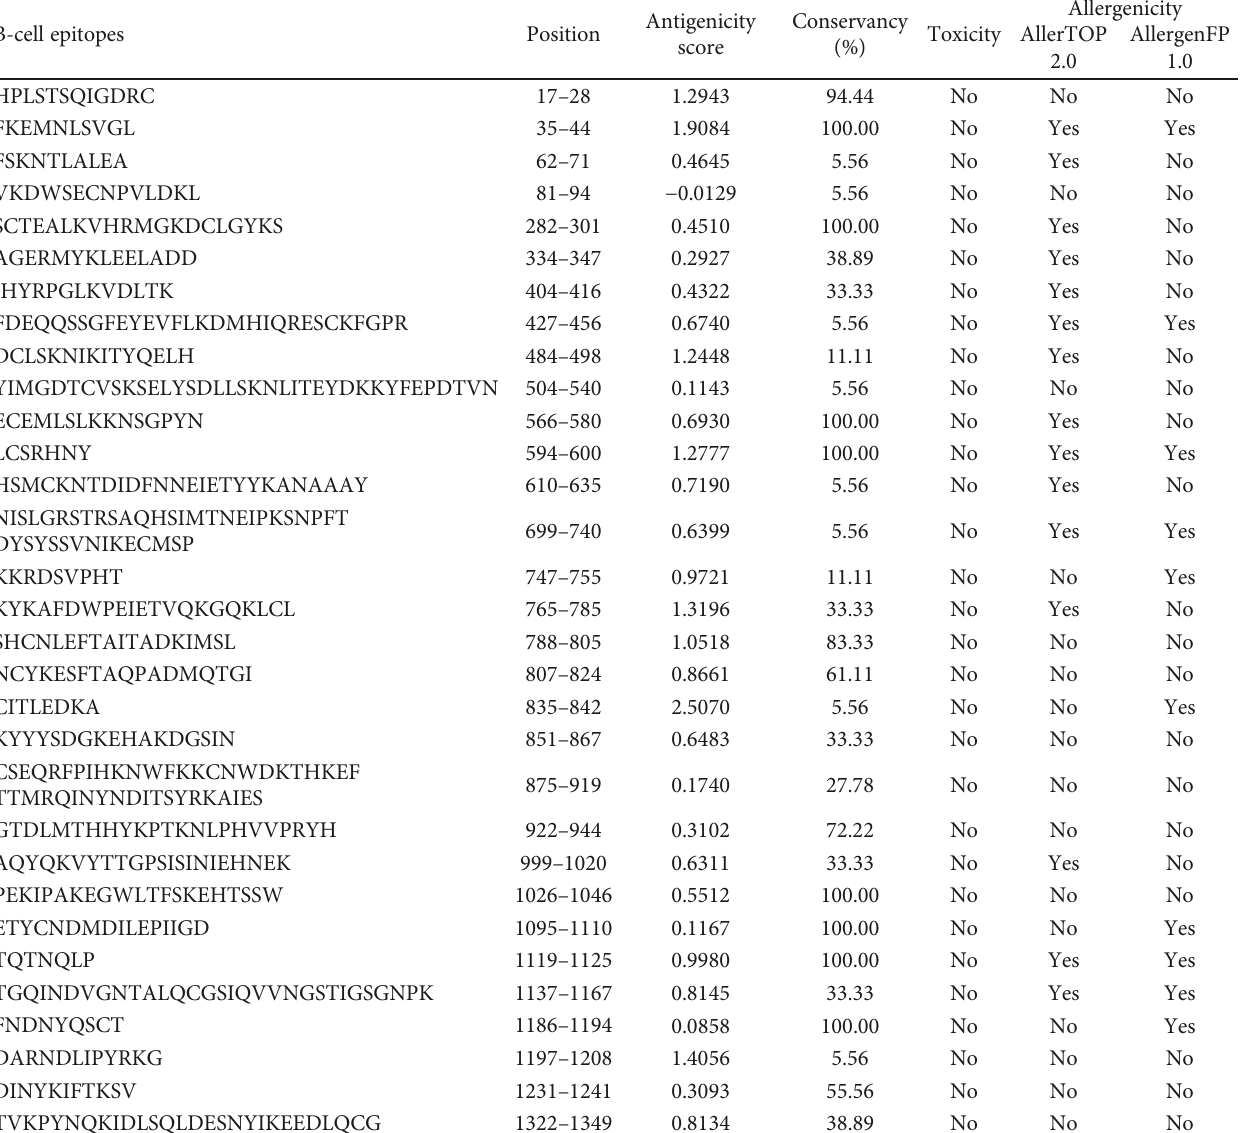
Table 3: Linear B-cell epitopes of the polyprotein of OROV predicted by BepiPred-2.0. B-cell